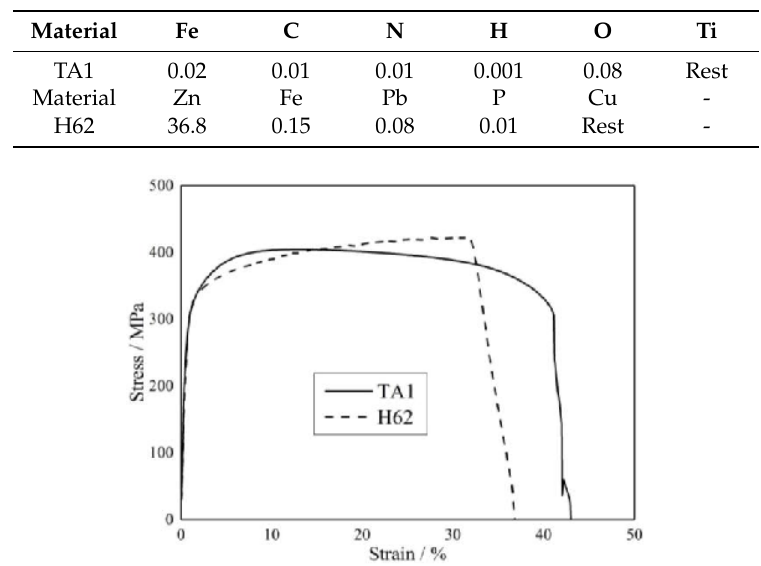
Figure 1. Stress–strain curves for TA1 and H62 sheet materials.